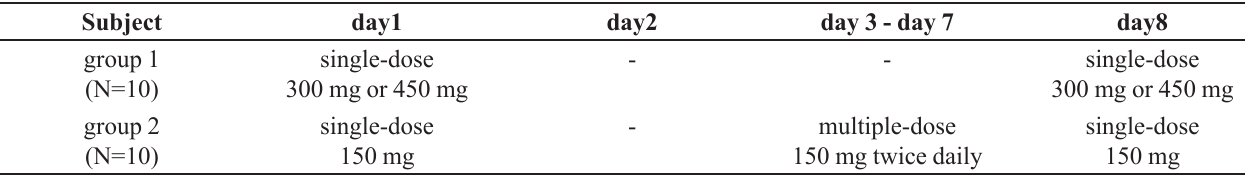
TABLE I - The randomization scheme of subjects